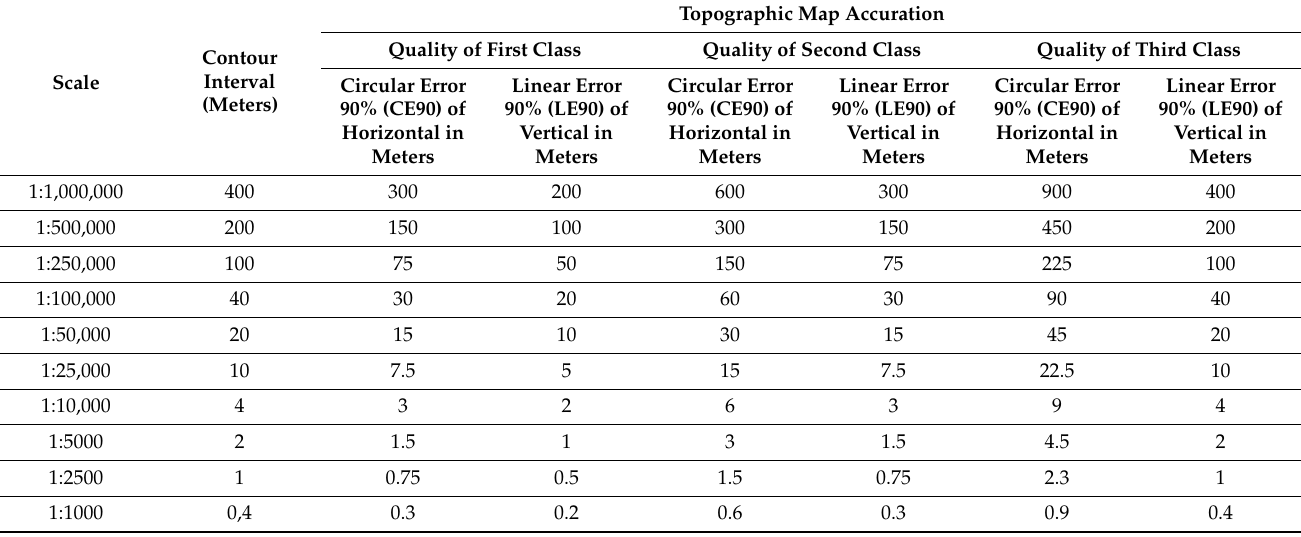
Table 1. Geometric accuracy on the national topographic map of Indonesia.